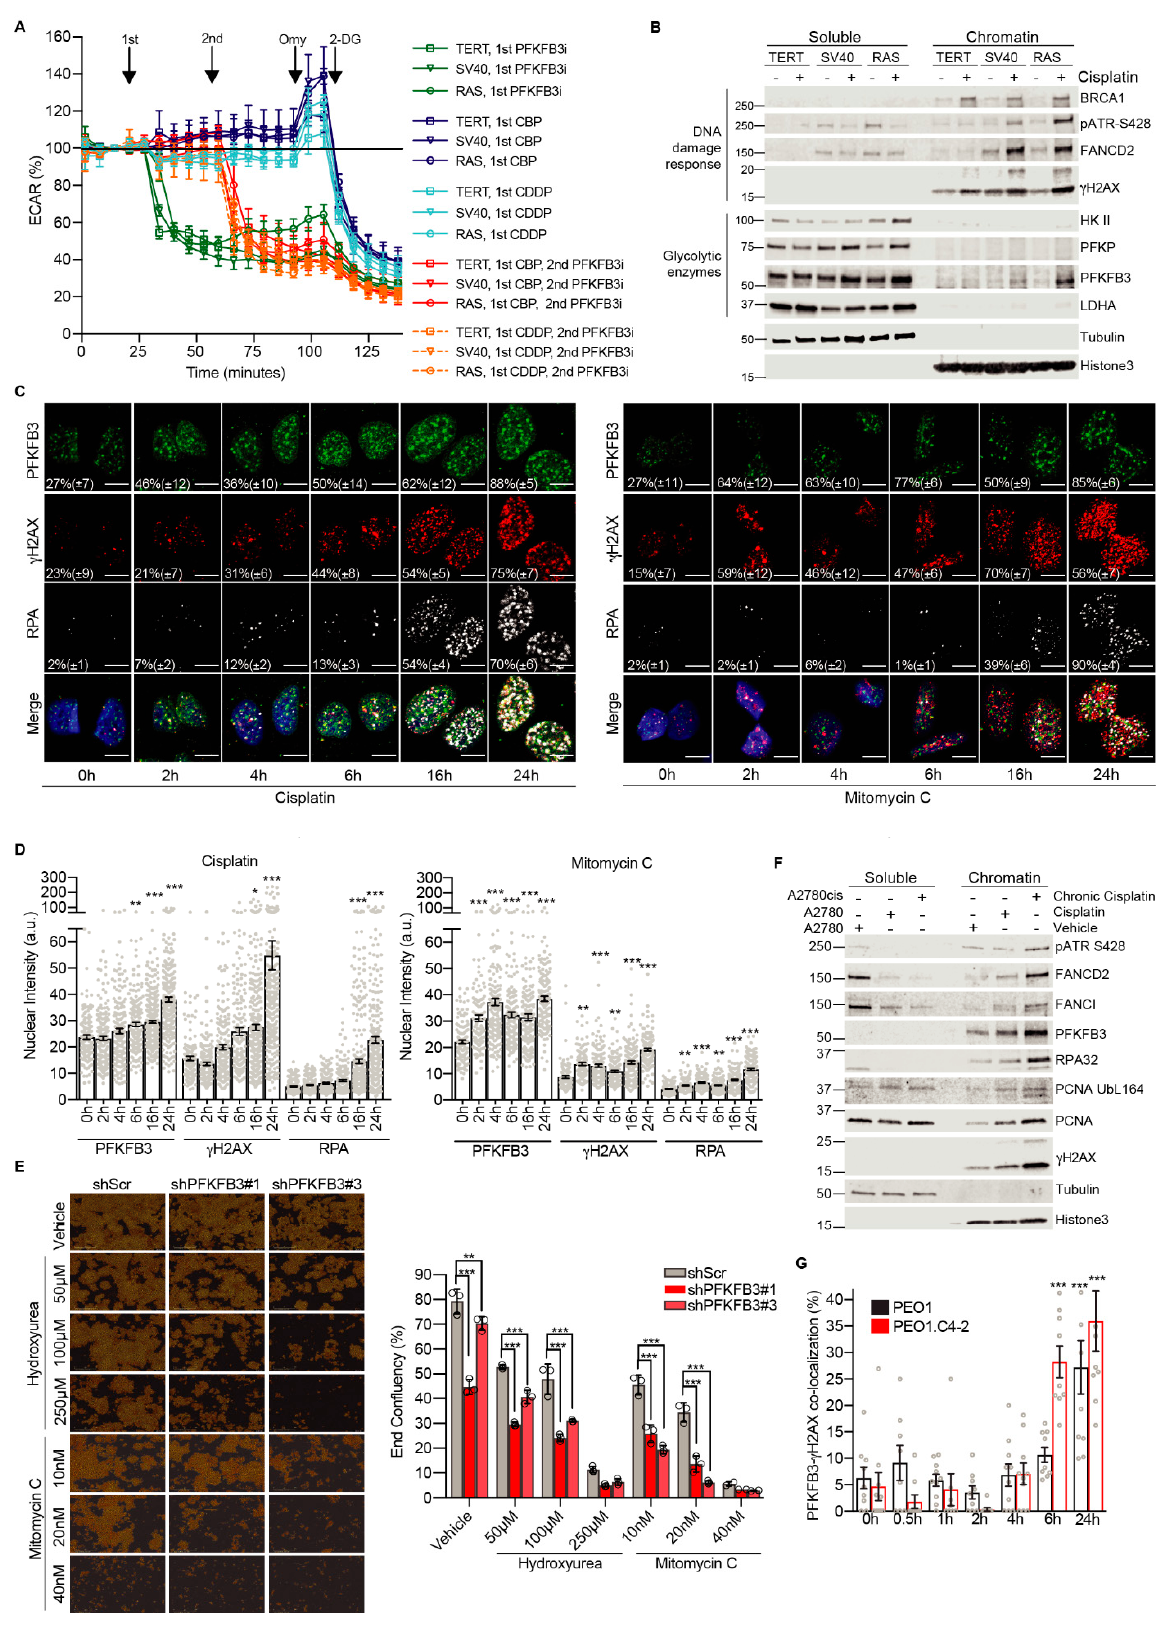
Figure 2. Cancer-specific PFKFB3 nuclear localization in response to FA pathway activation. ( A ) Extracellular acidification rate (ECAR) in BJ fibroblast transformation series; TERT (non-malignant), SV40 and RAS (malignant) cell lines. Cells were treated with either PFKFB3i (10 µM), carboplatin (CBP, 100 µM), or cisplatin (CDDP, 100 µM) at indicated time points, all